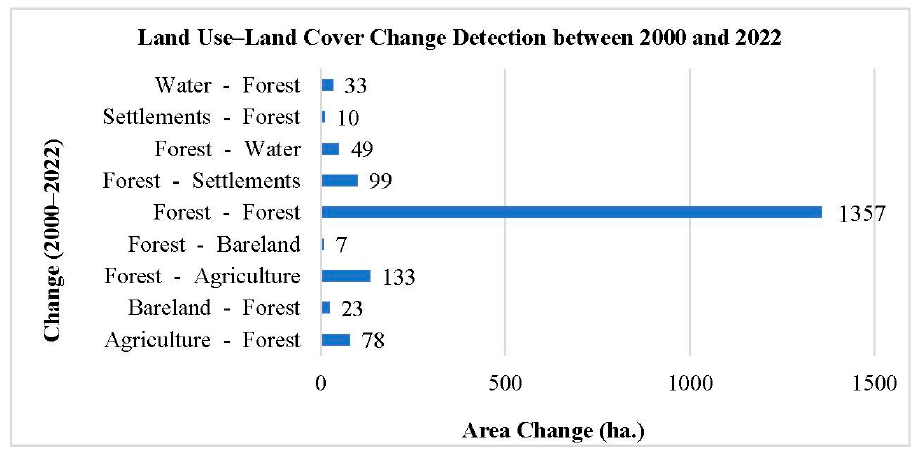
Figure 7. Histogram showing changes in land use cover between 2000 and 2022 in the Ghodaghodi Lake Complex, Nepal . Table 8. Shannon’s Diversity Index Calculated from sample plots.